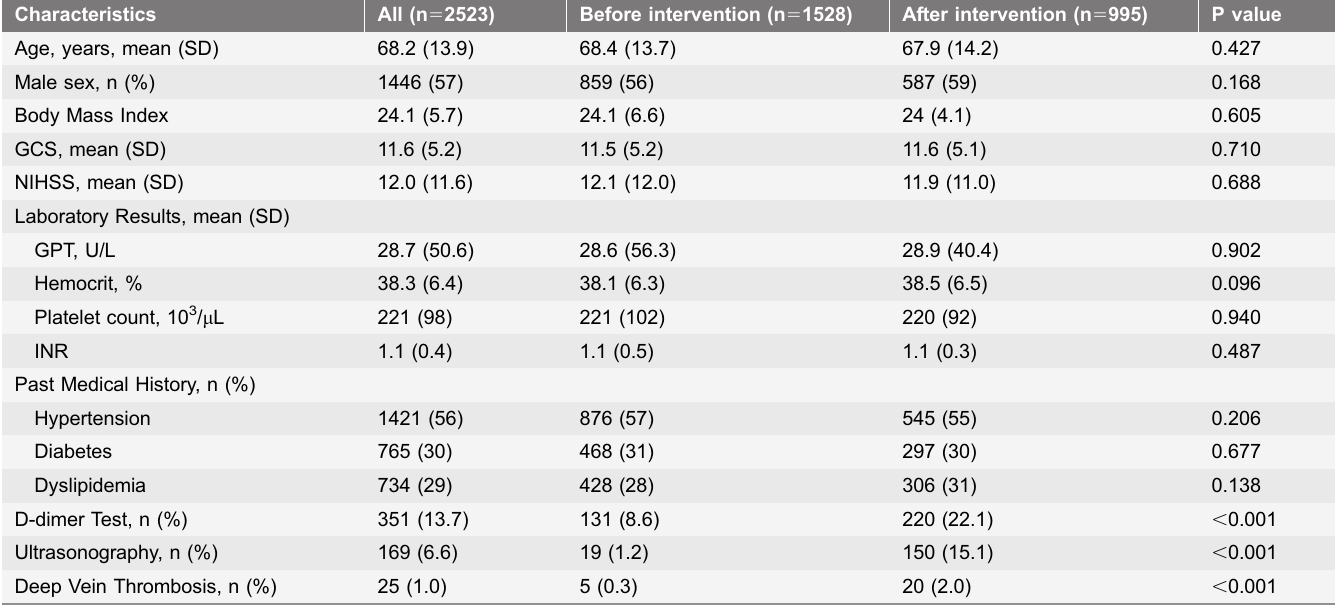
Table 1. Baseline characteristics of the study patients.